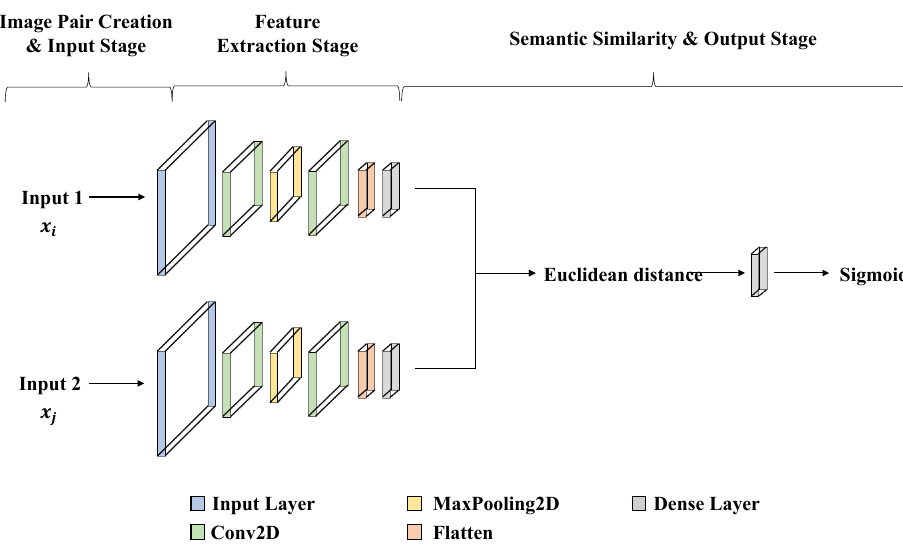
Figure 9. Two convolutional layer SNN’s